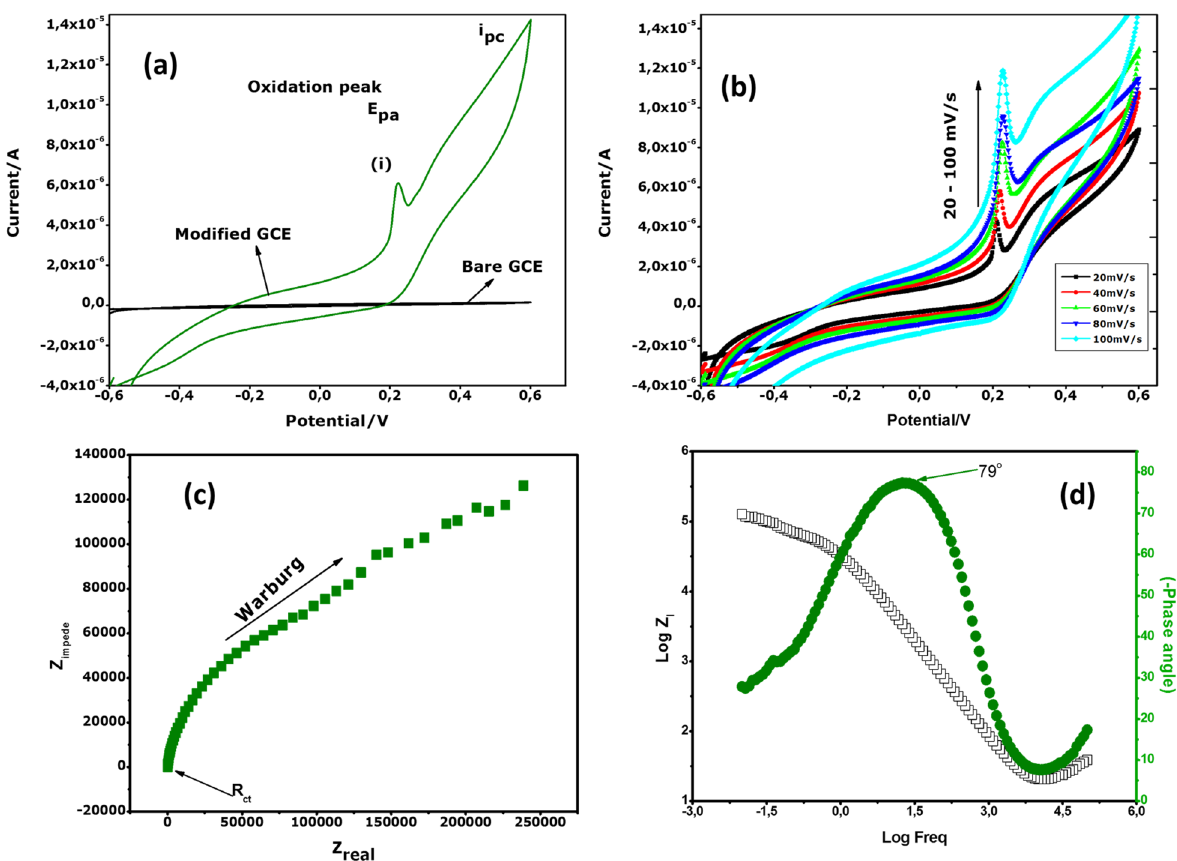
Figure 8. Cyclic voltammetry (CV) curves at 50 mV/s ( a ), CV at various scan rates ranging from 10 to 60 mV/s in 0.1 M NaOH ( b ), Nyquist ( c ), and Bode plot ( d